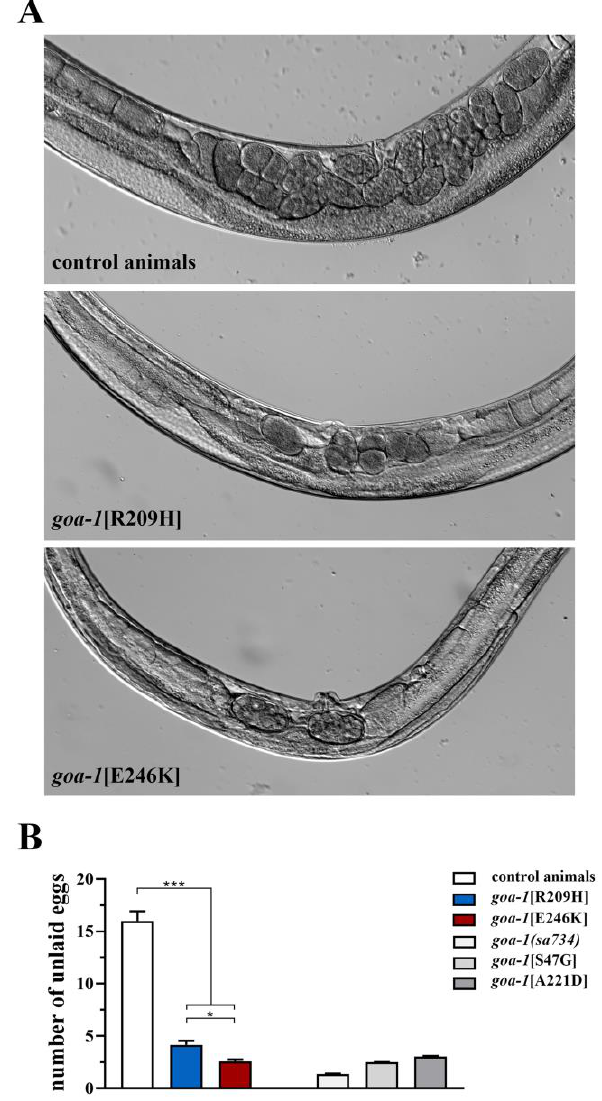
Figure 1. goa-1 [R209H] and goa-1 [E246K] animals show increased egg laying activity. ( A ) Representative images of mid-body regions of control animals (upper panel) and goa-1 mutants (lower panels). Retained eggs are visible as oval objects inside the body of adult hermaphrodites. Wild-type worms displayed 15 unlaid eggs on average, while G α o mutants retained only a few eggs in their uterus. Magnification is constant in all images. ( B ) The egg laying activity is quantified as the number of eggs present in the uterus (* p < 0.05 and *** p < 0.0001; one-way ANOVA with Bonferroni correction). Twenty animals for each genotype were tested. Data represent means ± SEM of multiple observations. Data collected in our previous study [18] are included in panel B for comparison (gray bars). sa734 is a null allele of goa-1